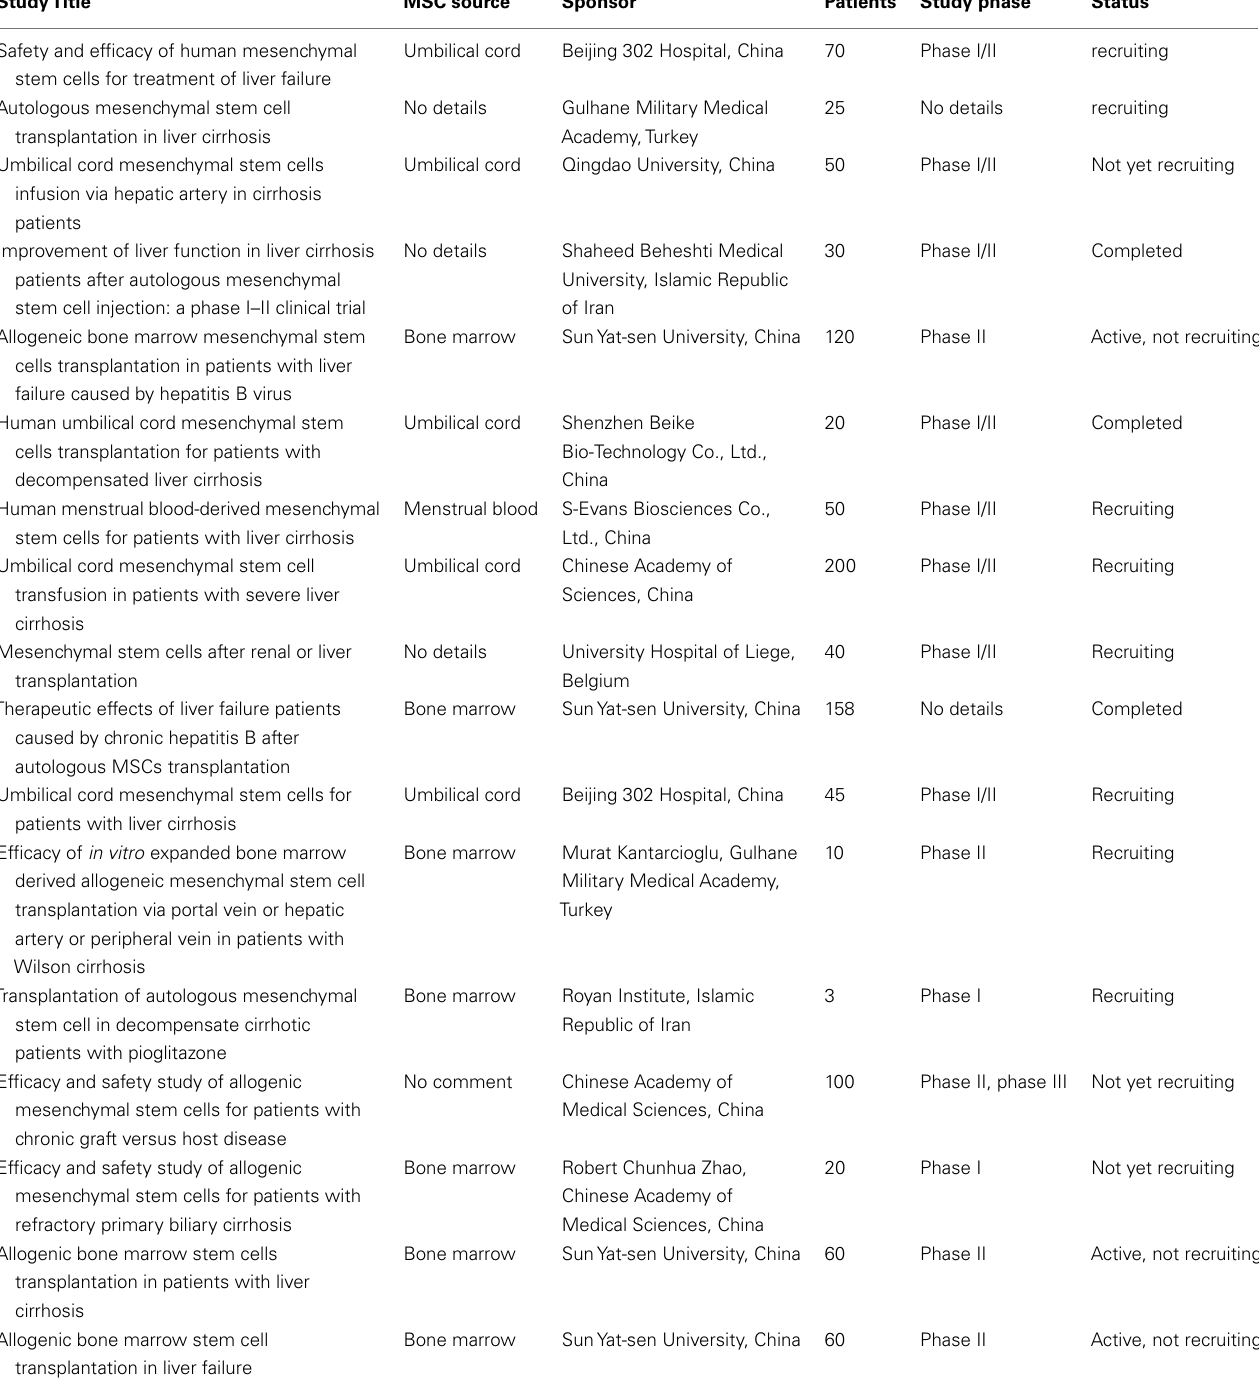
Table 1 | Summary of clinical trials involving mesenchymal stem cells of different tissue sources for the treatment of chronic liver